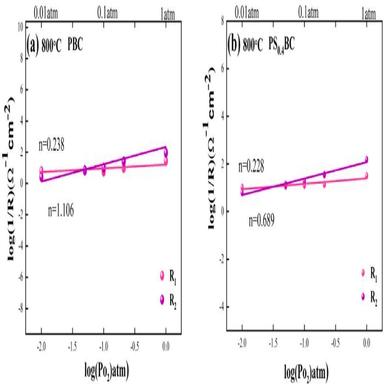
(a–b) The PO2 dependence of Rp of PBC and PS0.4BC at 800 ◦C in different partial oxygen pressures.